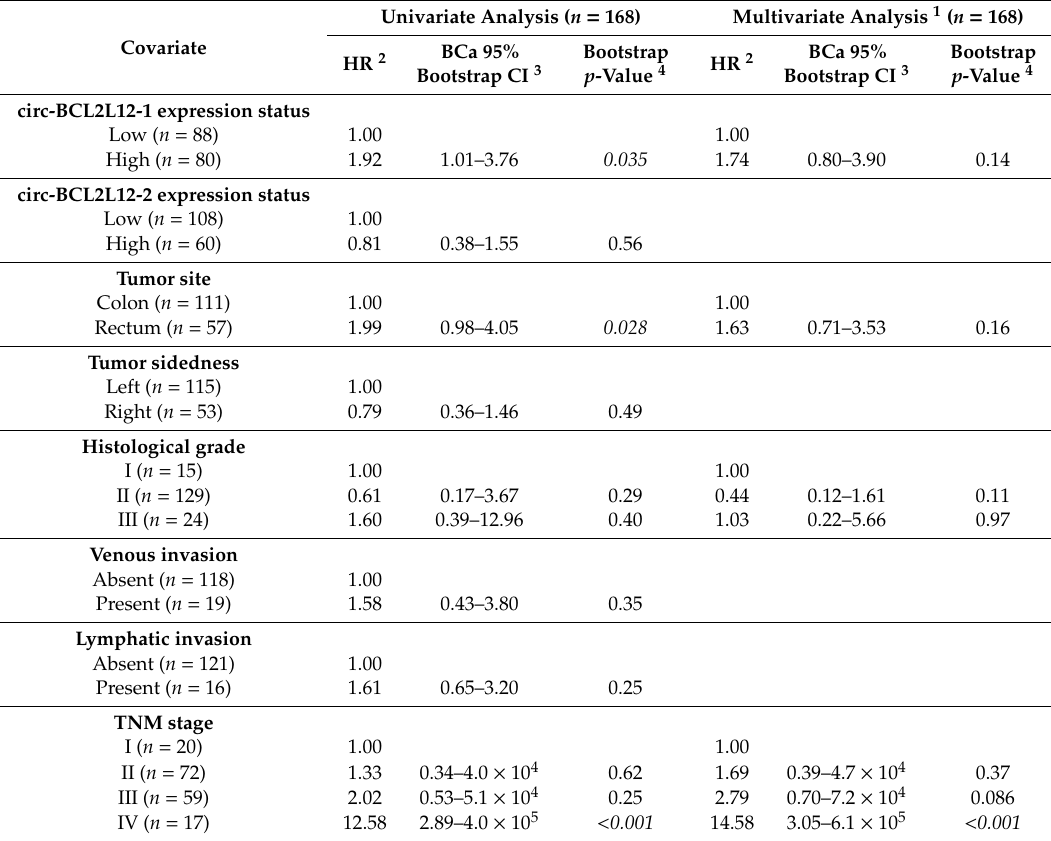
Table 4. Expression status of BCL2L12 circRNAs and overall survival (OS) of colorectal cancer (CRC)